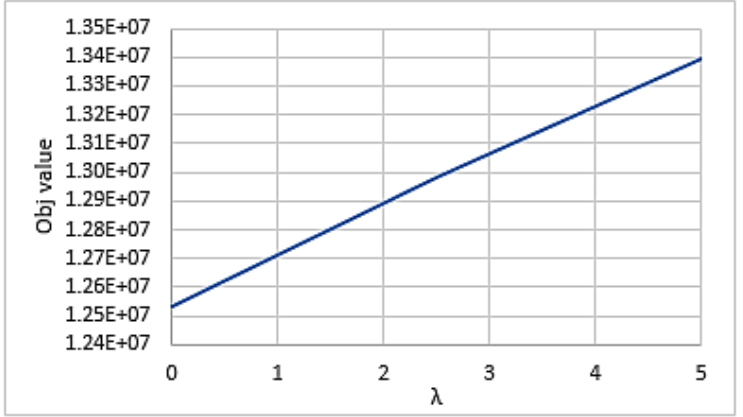
Fig. 5. Effect of λ changes on obj.